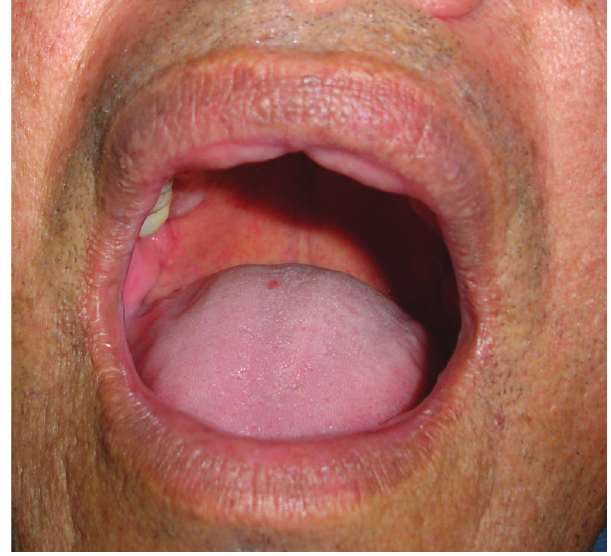
local anesthesia (Figure 2). The incision was subsequently sutured (Figure